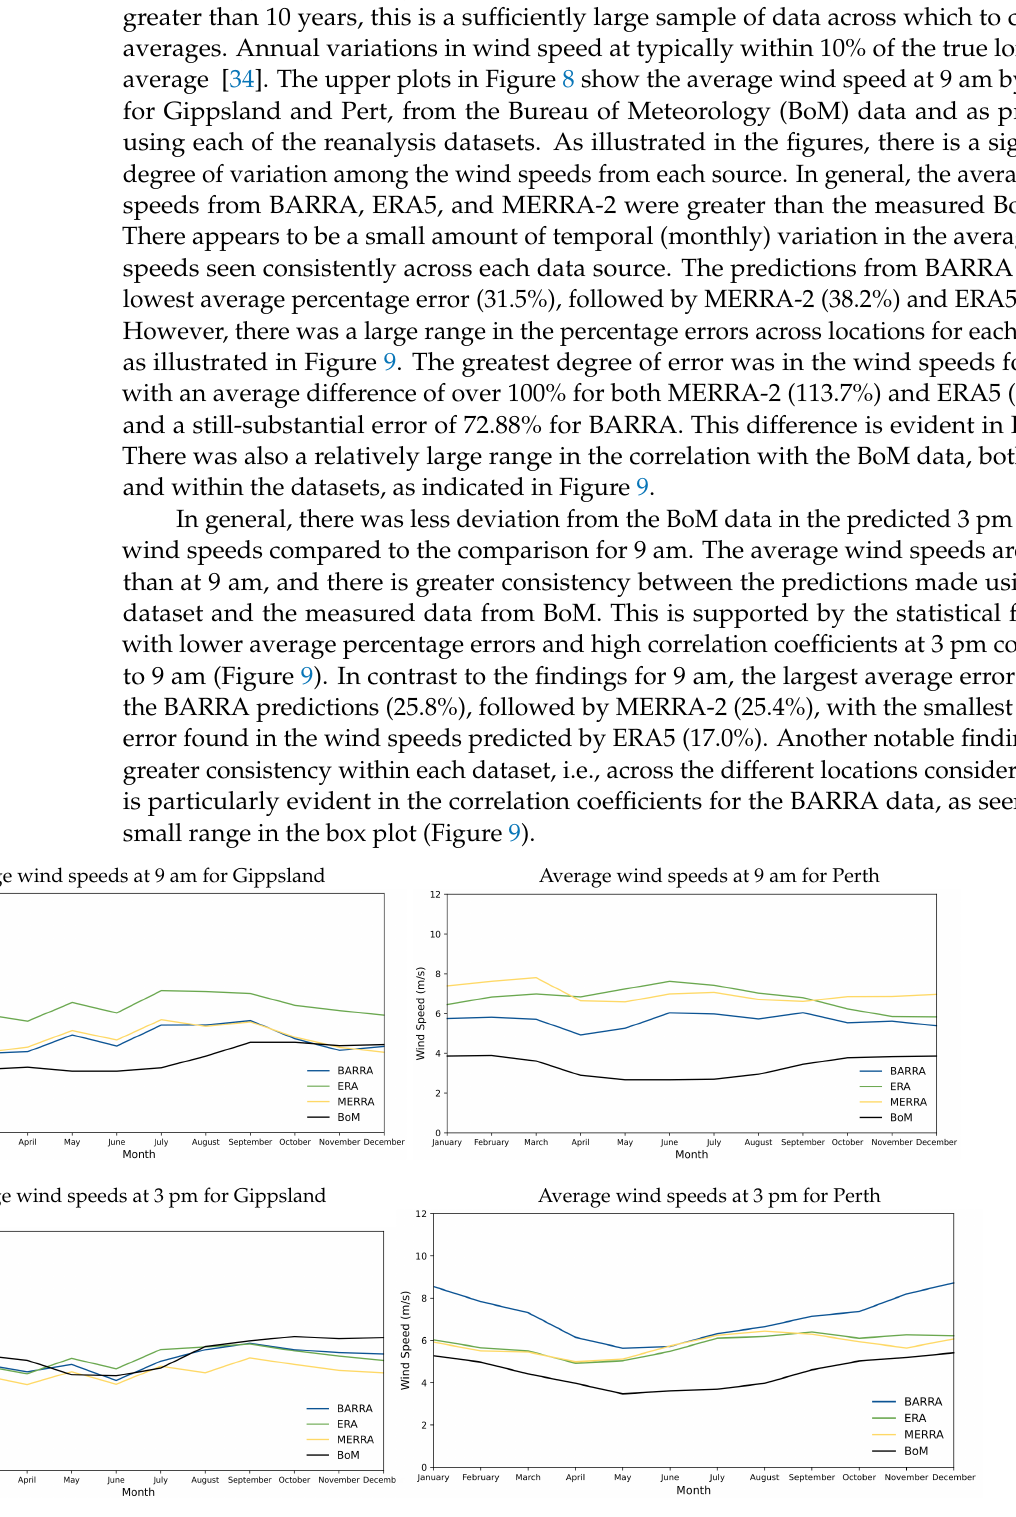
Figure 8. Predicted average wind speeds and BoM weather station data for Gippsland and Perth at 9 am and 3